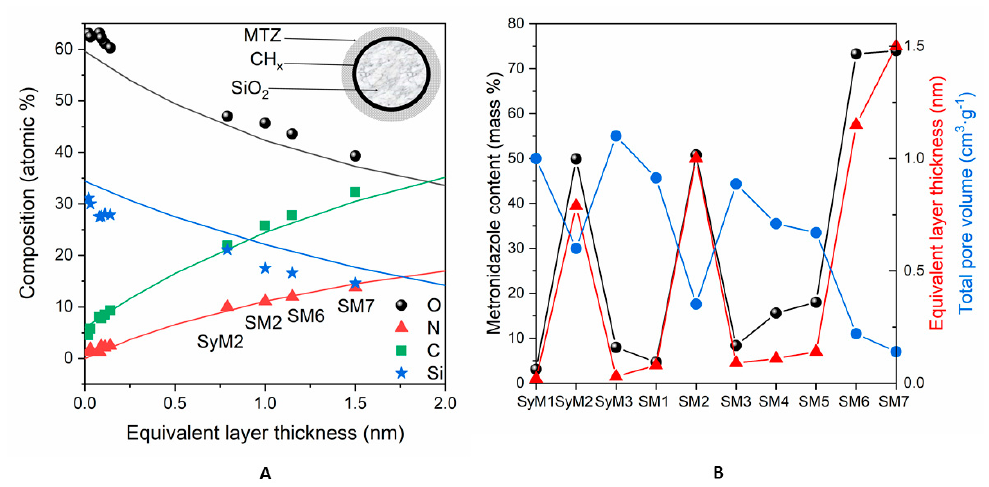
Figure 3. ( A ): Surface chemical composition (atomic %) of the samples containing MTZ adsorbed on silica, calculated with the infinitely thick homogeneous sample model. Continuous lines are simulated data, while dots are the measured samples. Abscissae are the equivalent layer thickness (nm) of metronidazole, calculated by the layers-on-sphere model. ( B ): Comparison of the active agent content (mass %) of the samples with the corresponding equivalent layer thickness (nm) and total pore volumes (cm 3 g − 1 ).